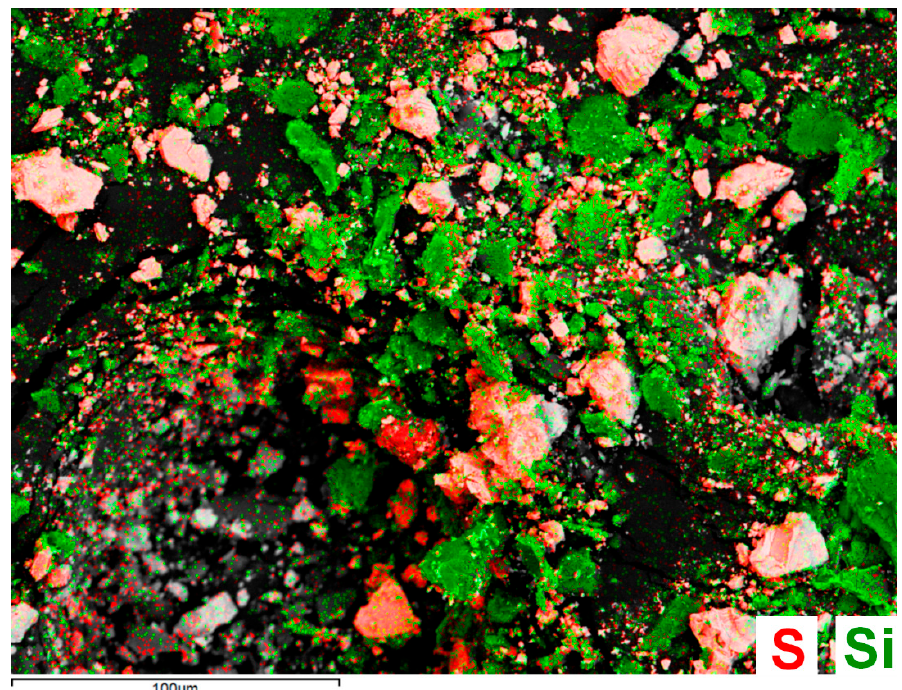
Figure 6. S and Si EDS maps acquired on the powdered mineral sample of Las Cuevas.